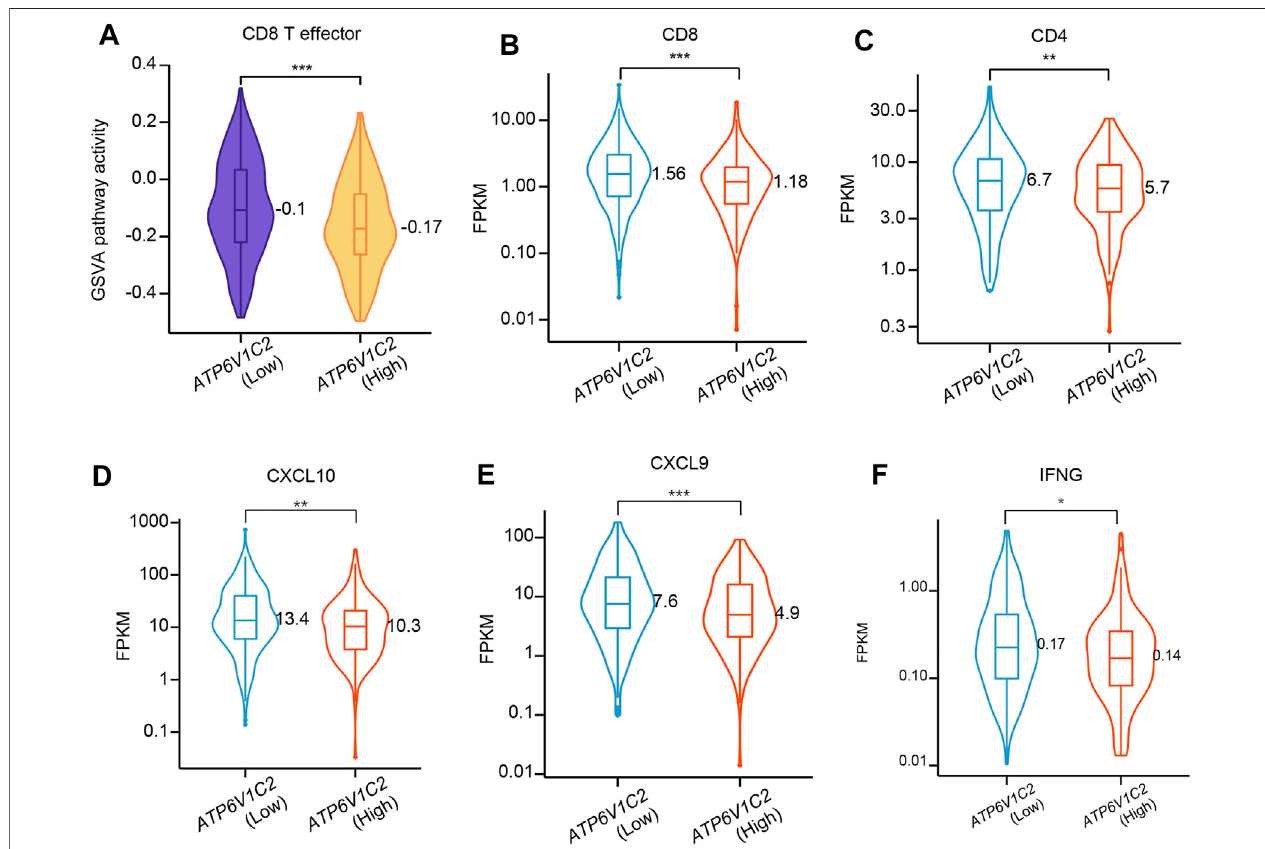
FIGURE 5 | The difference in CD8 T effector pathway activity between ATP6V1C2-high and -low groups. (A) CD8 T effector pathway activity; (B) CD8 expression; (C) CD4 expression; (D) CXCL10 expression; (E) CXCL9 expression; (F) IFNG expression. *, **, and *** indicate p < 0.05, p < 0.01, and p < 0.001, respectively. FPKM: Fragments per kilobase of exon model per million mapped